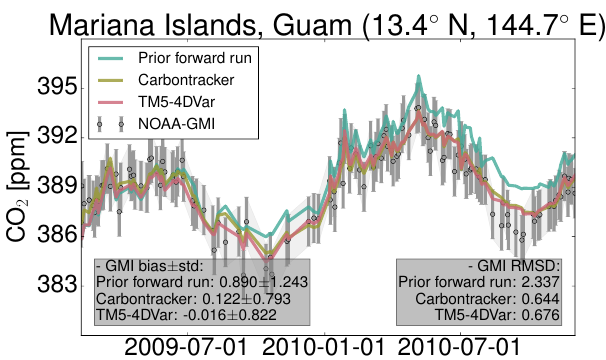
Figure 3. Time series of measured and modeled CO 2 concentra- tions from CarbonTracker and TM5-4DVar at Guam, Mariana Is- lands (non-assimilated). Also shown are the concentrations for ob- tained from a forward run of the transport model using the a priori background flux